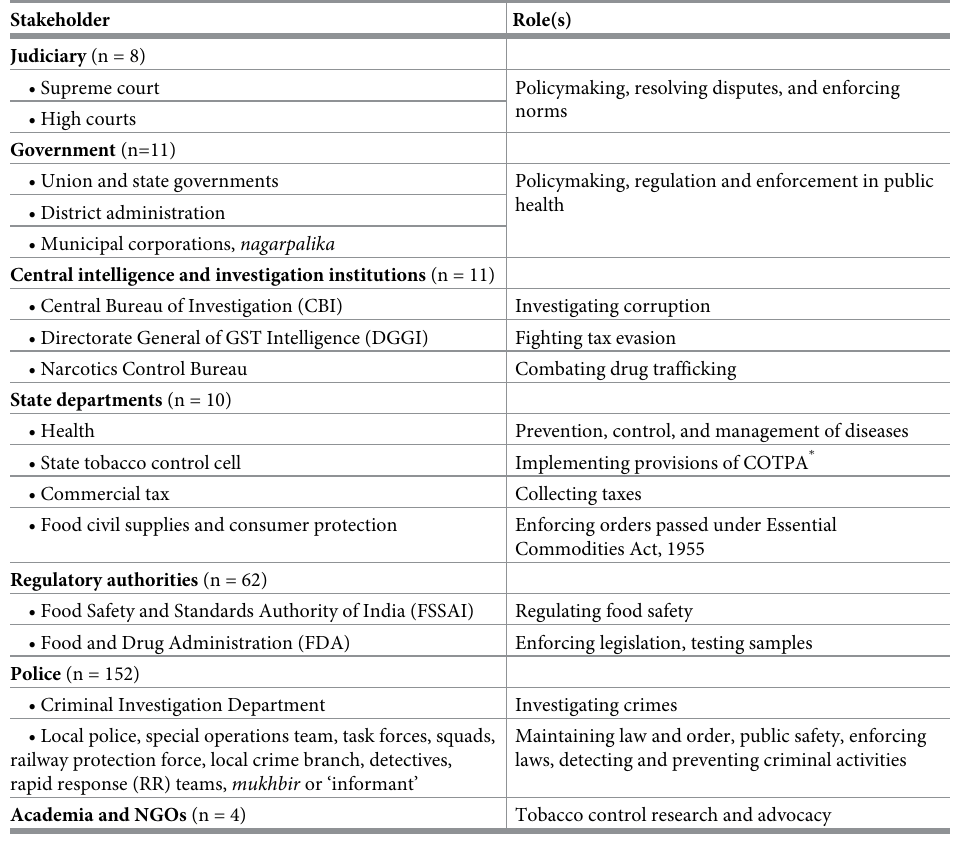
Table 3. Stakeholders and their roles in gutka ban enforcement as reported in the